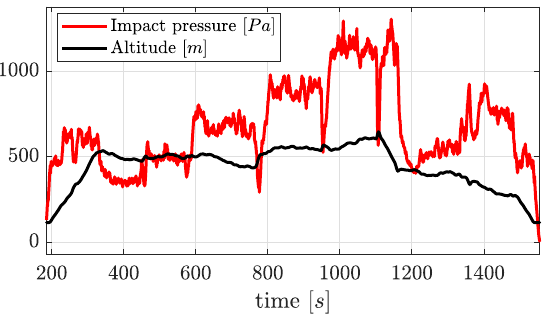
Figure 9. Example of flight test data reporting the impact pressure q c and the